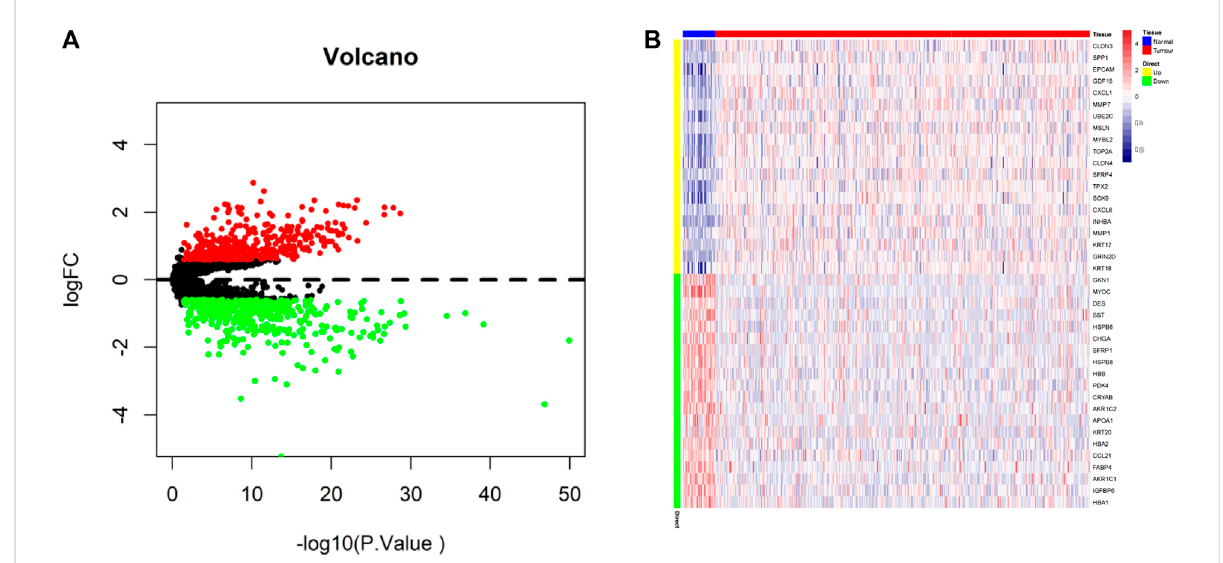
FIGURE 2 Identi fi cation of differentially expressed apoptotic genes. (A) Volcano map of differentially expressed apoptotic genes (Upregulated genes in red, downregulated genes in green). (B) TCGA-STAD of 20 up and downregulated differentially expressed apoptotic genes between tumor and normal